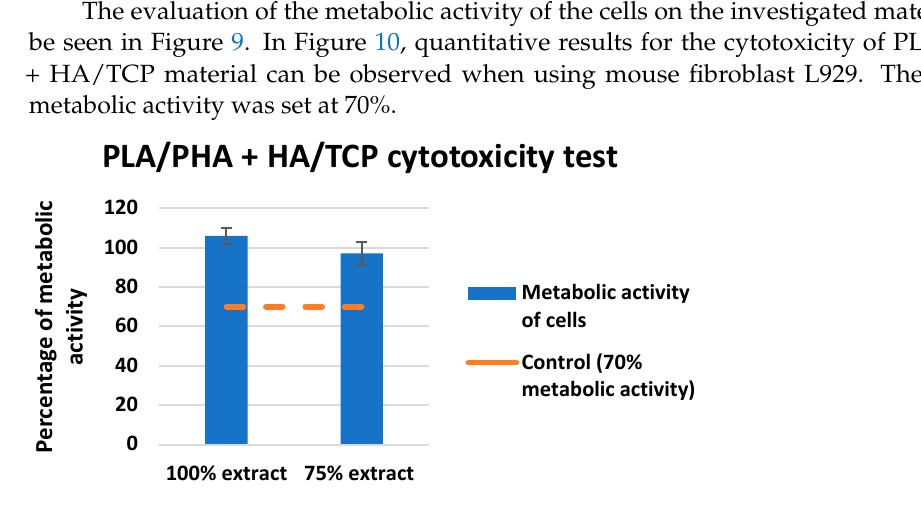
Figure 9. Cytotoxicity test for PLA/PHB + HA/TCP material using L929 fibroblast mouse.